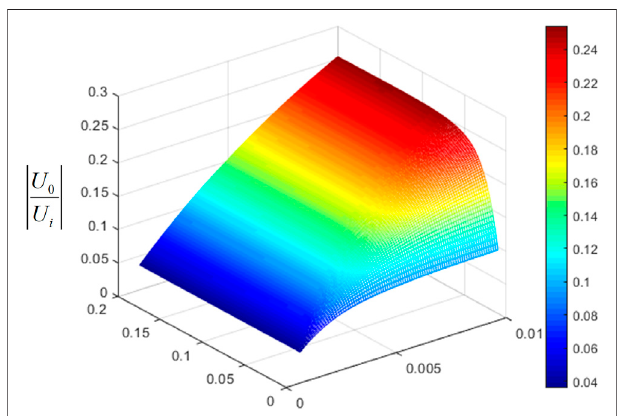
FIGURE 6 | Variation curve of transfer function amplitude with electrode width and insulation pad thickness.